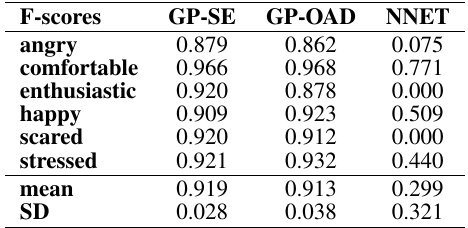
Table 2. Summary of F-scores using same data as previously, however, without SCL